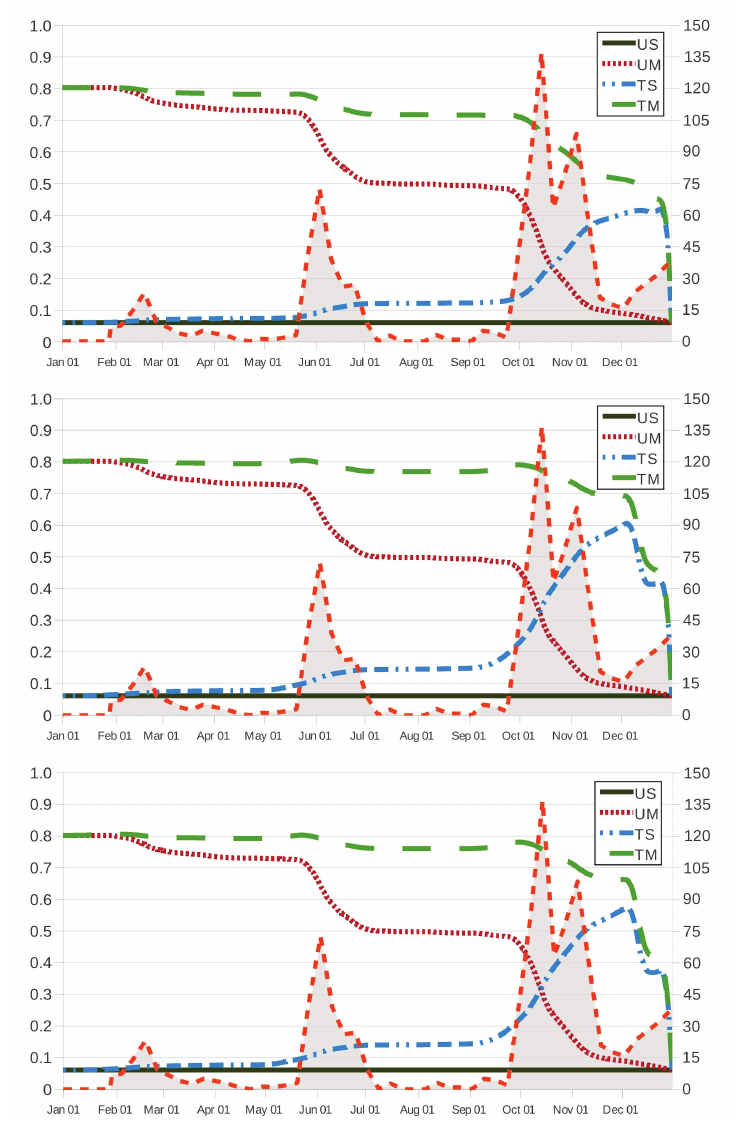
Figure 2. Effectiveness ef f s ( t 0 ; τ ) as a function of the intervention age t 0 for τ = 1 year and increments in the number of L 3 infective larvae in the small intestine (shaded area, right vertical axis). Scenario US, and grazing strategies UM, TS and TM with the anthelmintics ivermectin, fenbendazole and albendazole (from top to